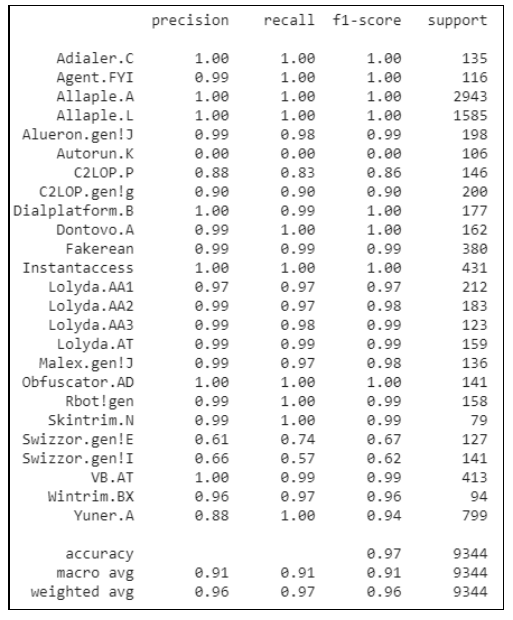
Figure 10. Performance metrics for CNN model with